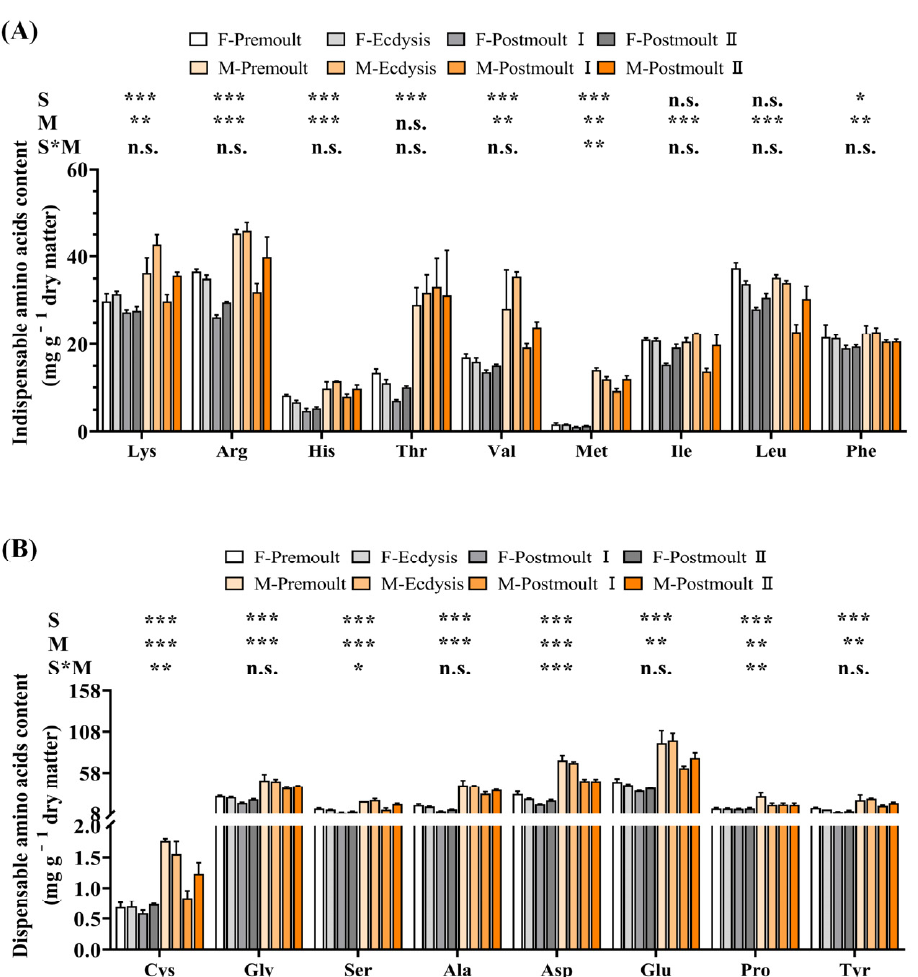
Figure 5. Effects of sex and moult stages on the amino acid composition (mg g − 1 dry weight) of the edible part of mud crab. ( A ) indispensable amino acids; ( B ) dispensable amino acids. Columns represent means with bars indicating the standard error (n = 3). Two-way ANOVA p -values are shown in each panel, with “S” representing the effects of sex, “M” representing the effects of moulting stages, and “S*M” representing the interaction between sex and moulting stages. n.s., not significant ( p ≥ 0.05). The differences were considered statistically significant at values of * p < 0.05, ** p < 0.01, and *** p < 0.001.